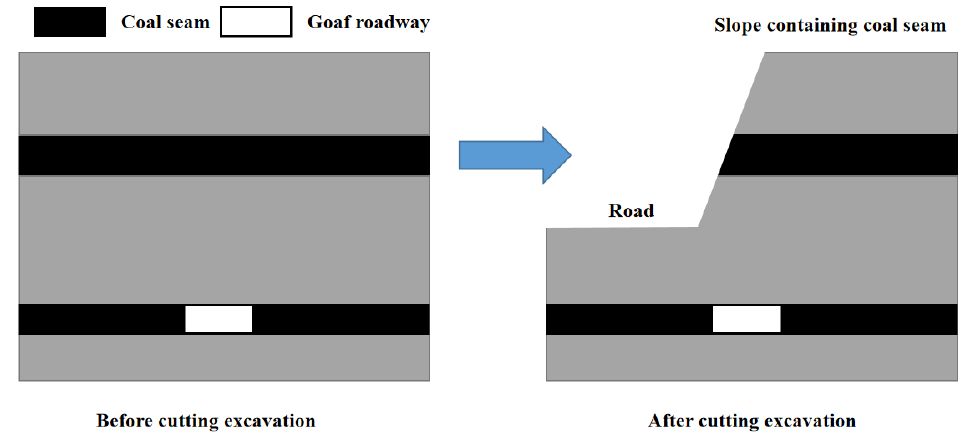
Figure 1. Formation process of a slope containing a coal seam in goafs.